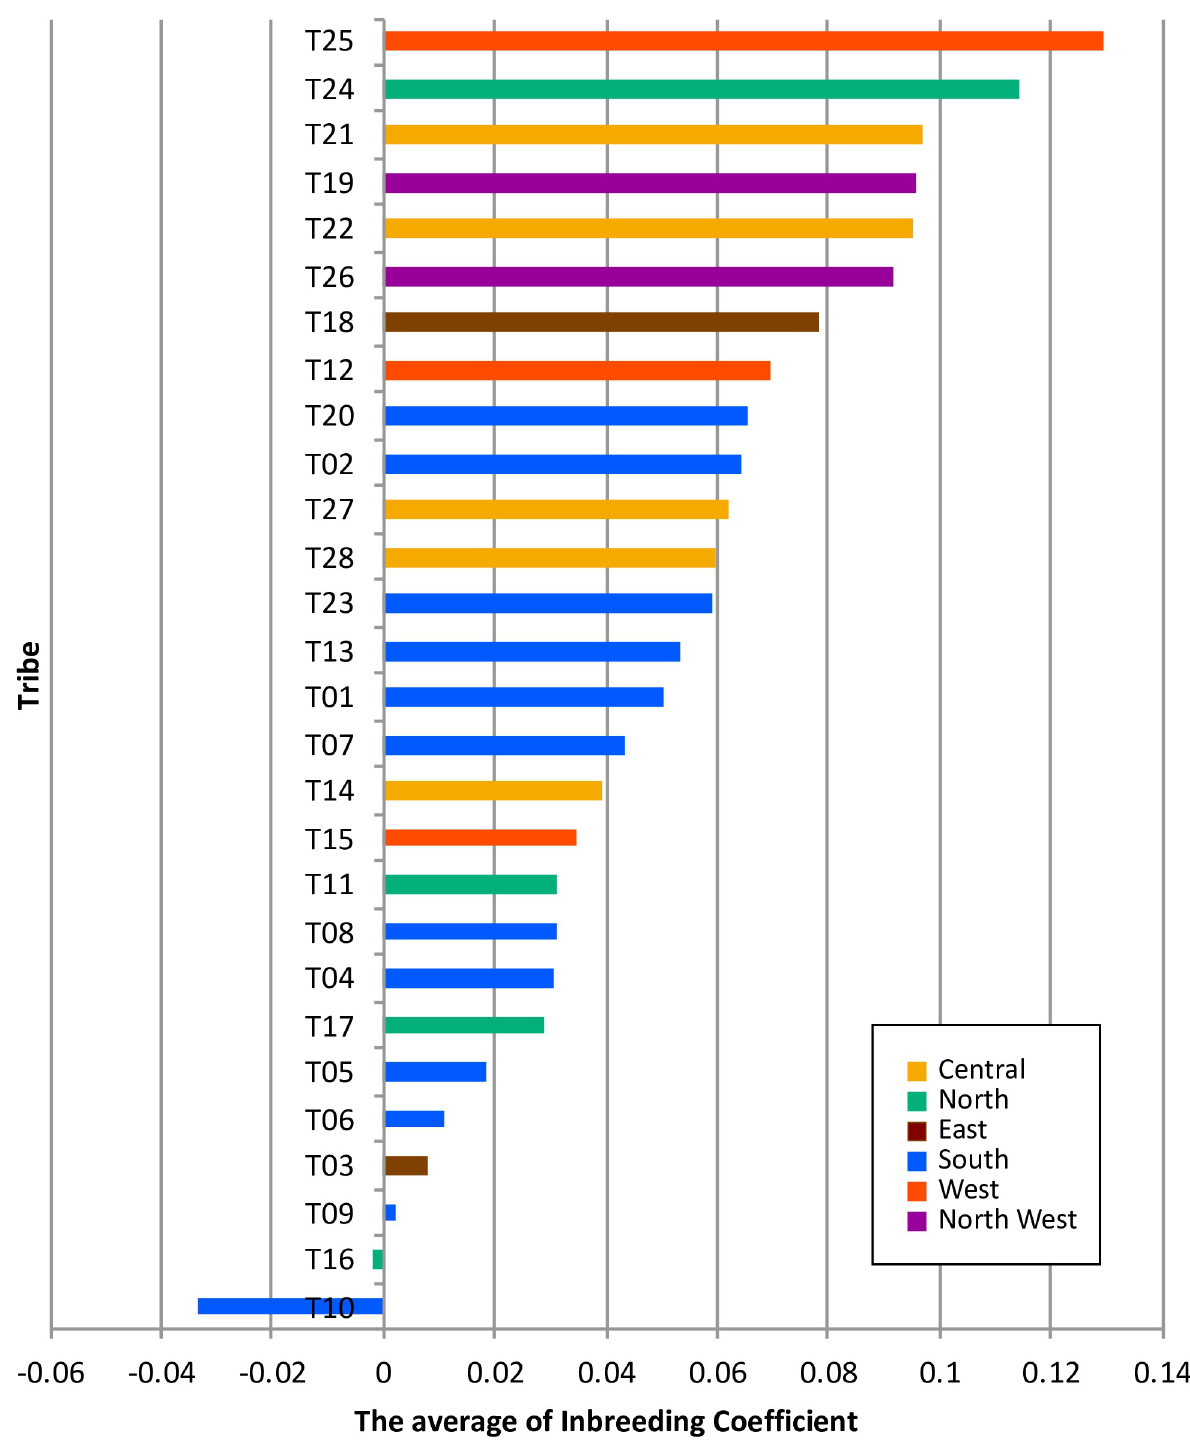
Fig 3. The average of inbreeding coefficients for 28 tribes. The bar chart shows the average of inbreeding coefficient for each tribe shown in decreasing order. The color indicates the regional group in the Arabian Peninsula. The inbreeding coefficient for each individual was calculated as “Fhat2” estimate using